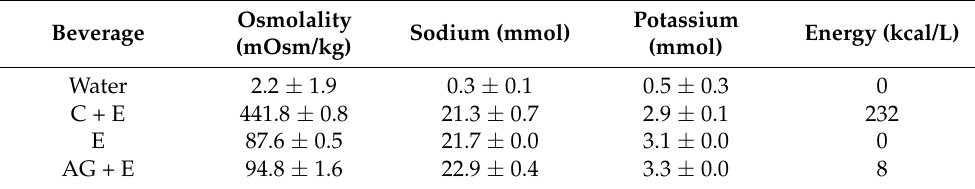
Table 2. Test beverage composition (measured values after conclusion of